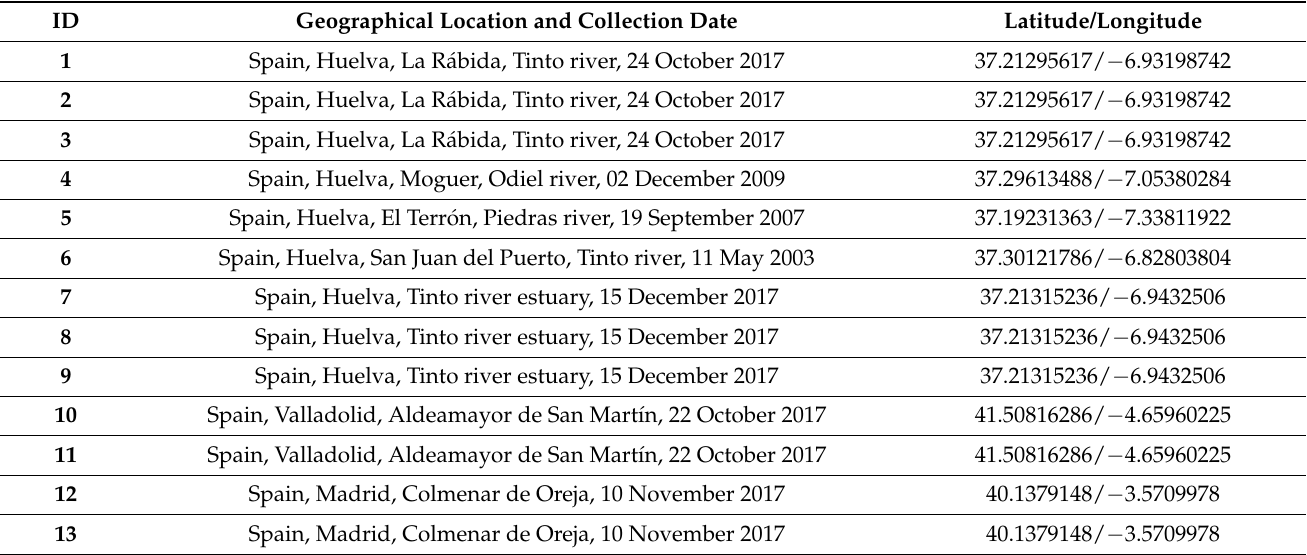
Table 1. Information about the sampled localities for S. patula